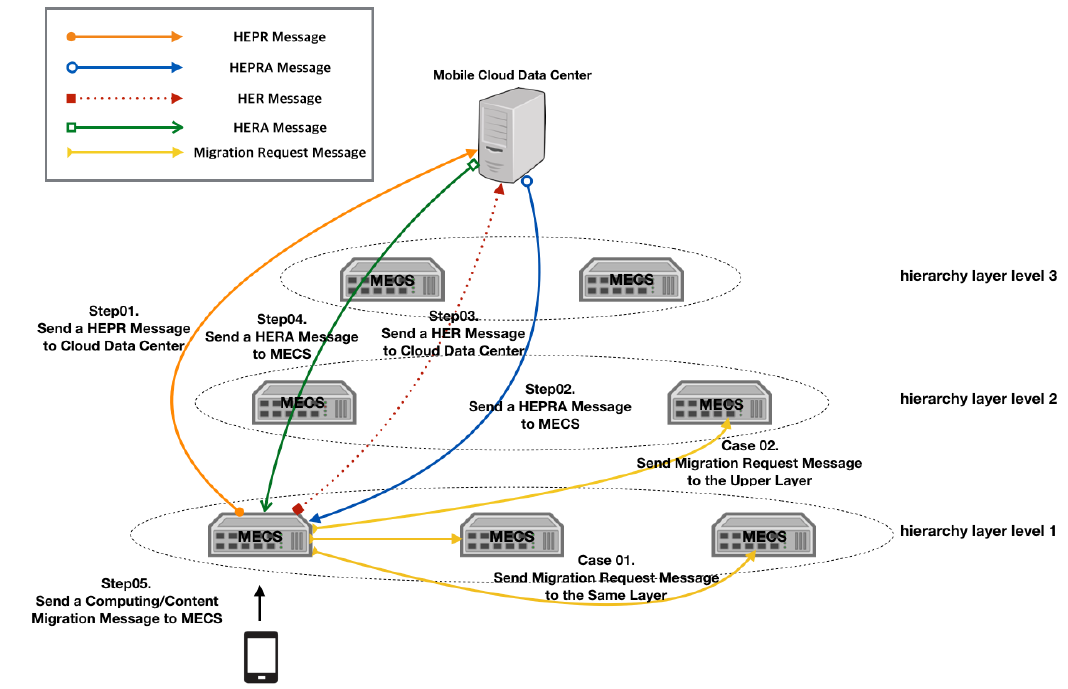
Figure 8. Message flow of the proposed context-aware hierarchical mobile edge computing (CoHEC)